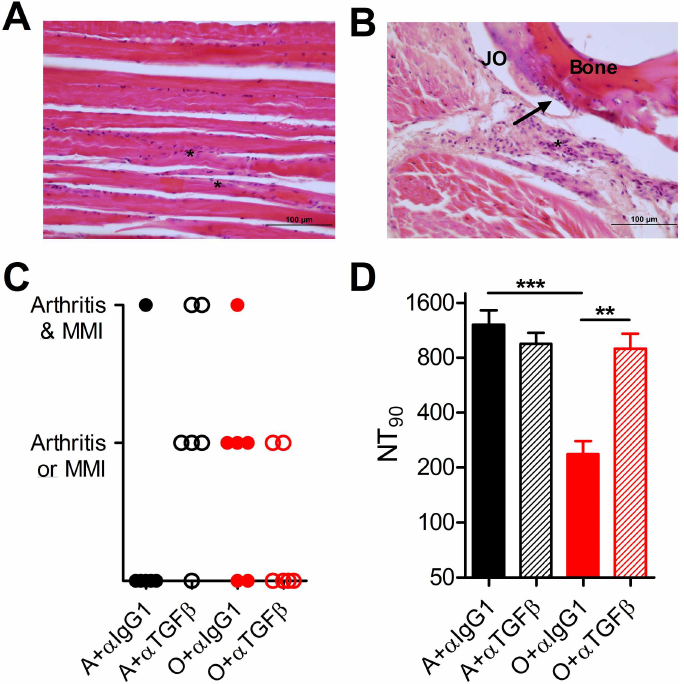
Fig 6. Blocking TGF β prevents chronic CHIKV-induced disease and restores neutralizing antibody titers in old mice. BlindedH&E stained histology sections were evaluatedby an anatomic pathologist for arthritis and metatarsal muscle Inflammation (MMI). (A) Representative metatarsal muscle inflammation. Astrisks indicate areas of inflammatory cells, muscle cell degeneration and pallor. H&E 40X magnification, bar is 100uM. (B) Representative arthritis. Arrow indicates area of articular cartilage erosion with infiltrate by neutrophils. Asterisk is an area of inflammation of the joint capsule characterized by the infiltrationof neutrophils and mild edema. JO = Joint. H&E 20X magnification. (C) Mice were scored as having either metatarsal muscle inflammation (MMI), arthritis, or both. (D) Plaque reduction neutralizing antibody titers were determinedat day 90 post-infection. Data are mean ± SEM (n = 11–12 per group). Statistical significance evaluatedby unpairedstudent’s t -test * P < 0.05; ** P < 0.01; *** P <